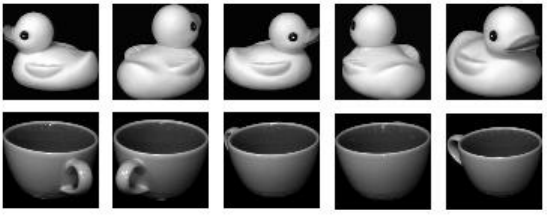
Fig.3. Sample images from COIL20 database.